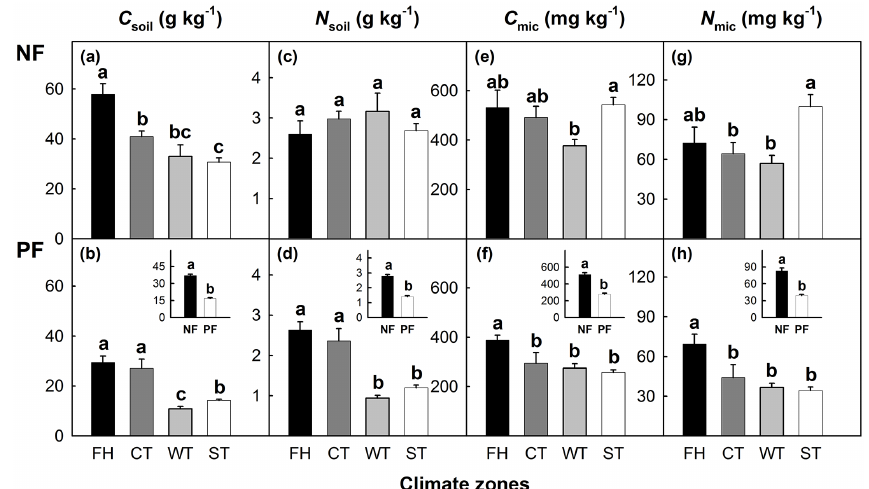
Figure 2. Comparisons of C soil (a, b) , N soil (c, d) , C mic (e, f) , and N mic (g, h) among climate zones and between management regimes. Inserted figures are the overall comparisons between the natural (NF) and planted forests (PF). C soil , N soil , C mic , and N mic stand for soil organic carbon, soil total nitrogen, microbial biomass carbon, and microbial biomass nitrogen, respectively. FH, CT, WT, and ST stand for frigid highland zone, cool temperate zone, warm temperate zone, and subtropical/tropical zone, respectively. Different lowercase letters denote significant differences among the climate zones or between the management regimes (mean ± SE, α = 0.05).